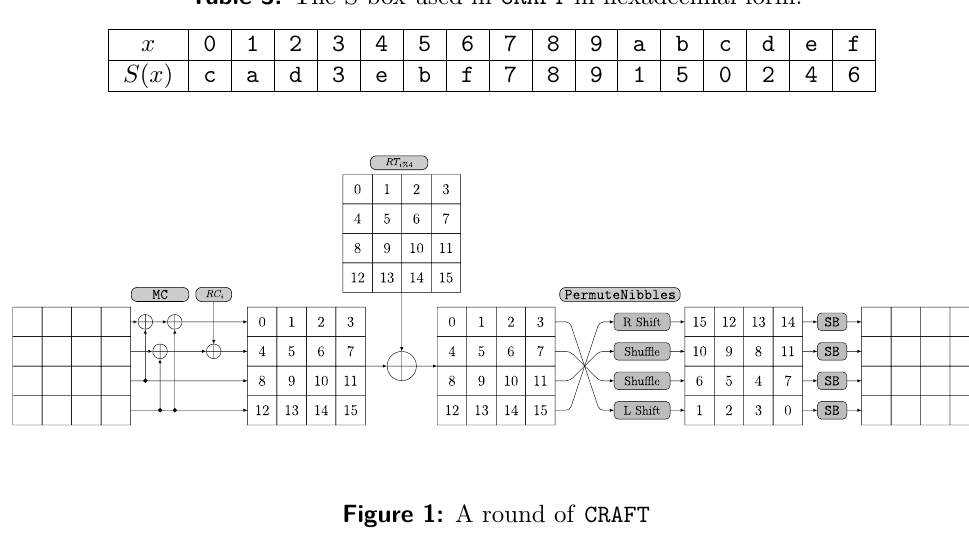
Table 3: The S-box used in CRAFT in hexadecimal form.